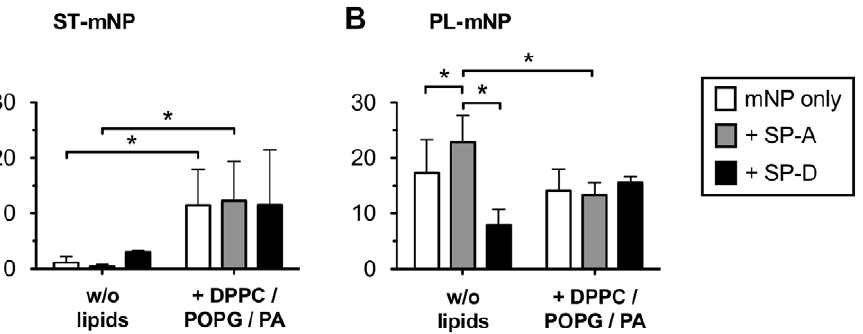
Figure 6. Modulation of SP-A – and SP-D – mediated macrophage association of mNPs by surfactant lipids. (A) Starch- (ST) or Phosphatidylcholine-modified (PL) magnetite nanoparticles (mNP; 1.532 6 10 10 /ml) were incubated with alveolar macrophages (AM; MH-S cells) for 90 min in the absence (mNP only in buffer) or presence of DPPC/POPG/PA vesicles (100 m g/ml) with and without 5 m g/ml SP-A or SP-D, respectively. Cells with Fl-1 . 10 1 were considered as positive cells for nanoparticle association and uptake (% positive cells). Data shown as mean 6 SD (n=6). Asterisk indicates a significant difference with p , 0.05.